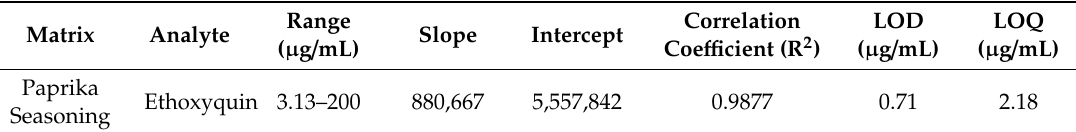
Table 4. Correlation coe ffi cients of the calibration curves, LOD and LOQ in paprika seasoning using LC-MS / MS.